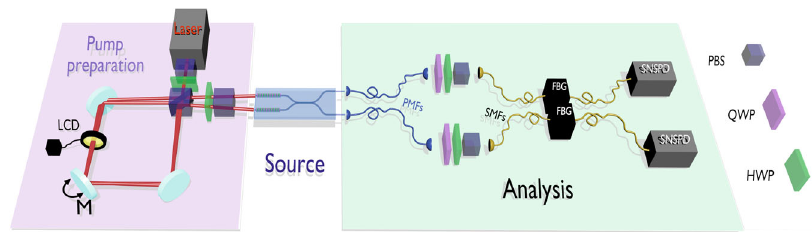
Fig. 5 Experimental setup for quantum measurements: the two pump beams are created within a Sagnac loop and displaced by rotating one mirror of the loop (M). The phase between the two beams is set via a liquid crystal device (LCD). After the chip the entangled state is measured with a standard polarization analysis setup: half waveplate (HWP), quarter waveplate (QWP) and a polarizing beam splitter (PBS). The photons are detected with superconducting nanowire single photon detector (SNSPD). Temporal delay is compensated with polarization maintaining fi bers (PMF) and fi ber Bragg grating fi lters (FBG) can be possibly inserted to fi lter the spectrum of the emitted